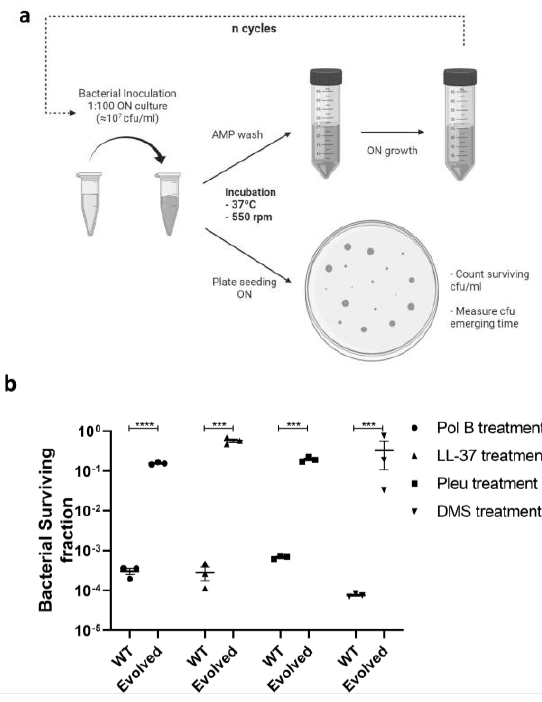
Figure 1. Periodic incubation of bacteria with AMPs ( a ) Development of tolerant strains in E. coli against the tested AMPs. Cell cultures were evolved for 10 successive cycles or until resistance was detected (PolB, after 8 cycles) ( b ) Bacterial survival fraction before and after the assay. Values are shown as the mean ± SEM and individual replicates are displayed. p -values are reported as indicated: *** p < 0.005; **** p < 0.001.